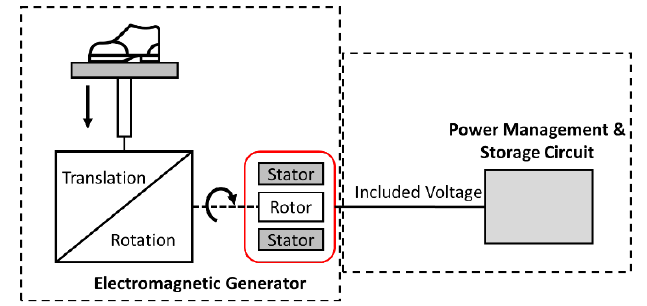
Figure 1. Genpath Concept Diagram.